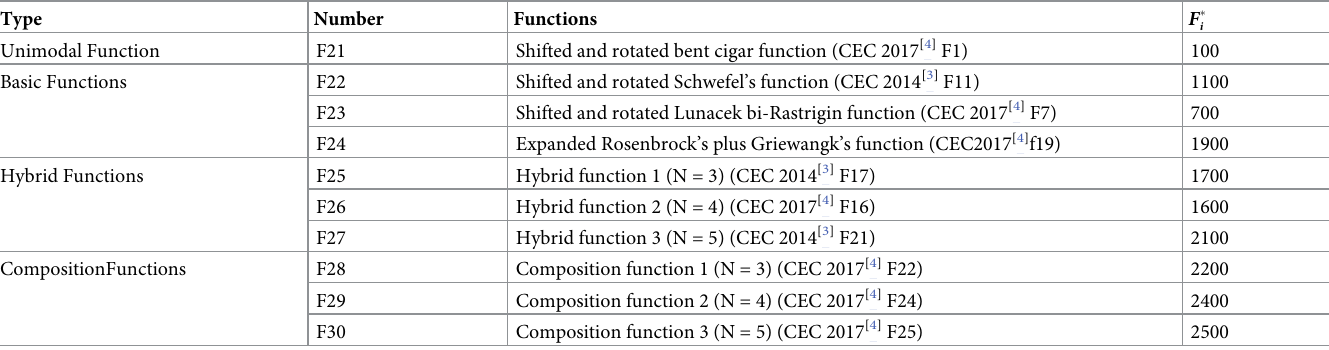
Table 3. Summary of the CEC2020 test